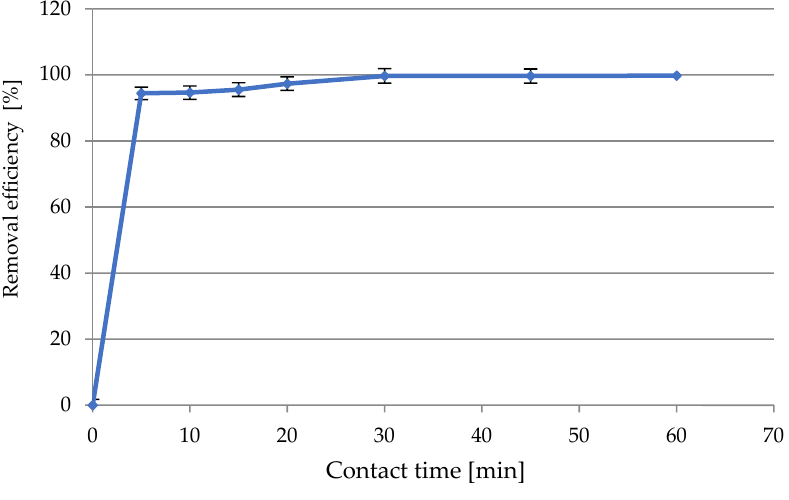
Figure 10. The effect of contact time on the Ni(II) ion removal efficiency. Pseudo-First-Order and Pseudo-Second-Order Kinetic